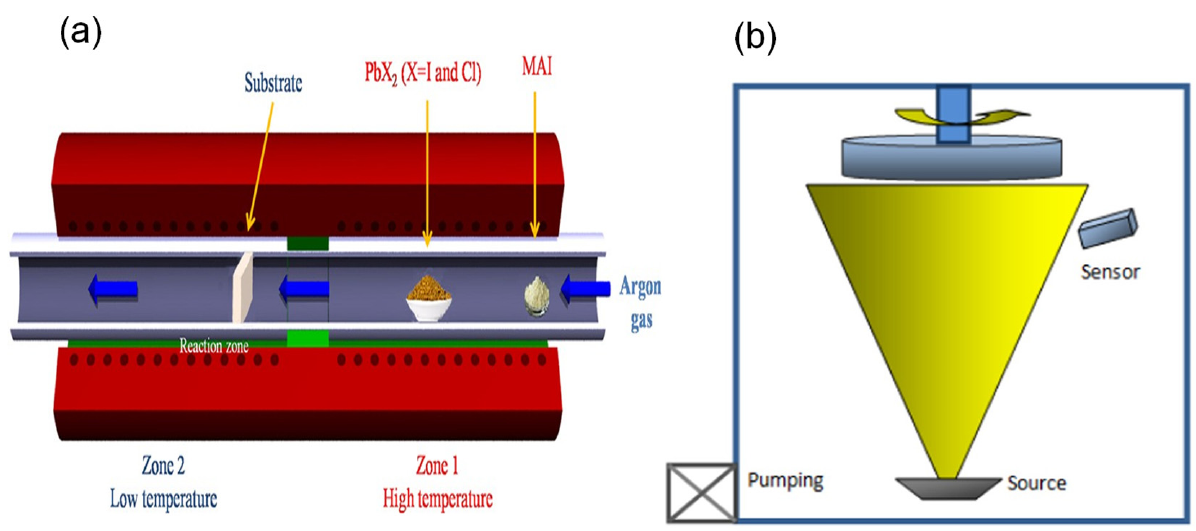
Figure 3. Type of vapor-based fabrication method: ( a ) chemical vapor deposition (CVD) [91]. Re- produced with permission from Ref. [91]. Copyright 2015 Scientific Reports. ( b ) Physical vapor deposition (PVD) [95]. Reproduced with permission from Ref. [95]. Copyright 2016 Scientific Reports.